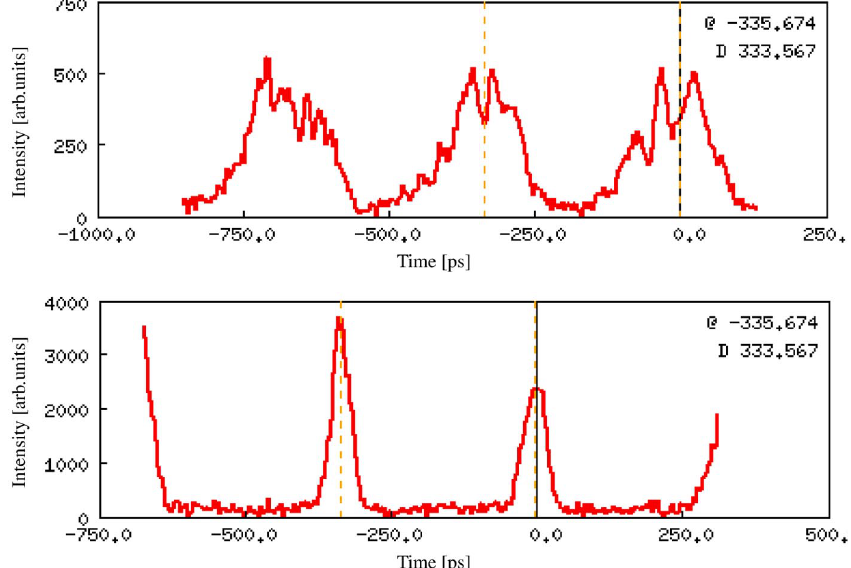
FIG. 16. (Color) Longitudinal intensity profile as measured with the streak camera. The top profile is taken during the second turn for the nonisochronous optics. The bottom image shows the distribution in the 60th turn for the isochronous optics.